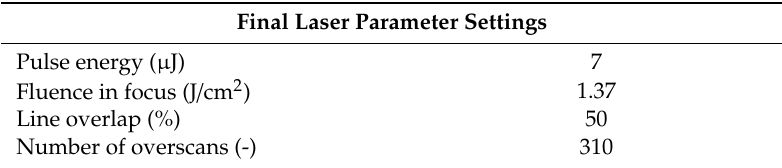
Figure 1. Simplistic illustration of the structure parameters and consideration of the contact angle measurement (1 = gap depth, 2 = gap width, and 3 = strut width, as well as contact angle parallel Θ ‖ and perpendicular Θ ⊥ to the groove direction). Table 1. Final laser parameter settings for processing of groove-structured surfaces with gap width of 20 µm and gap depth of 10 µm.